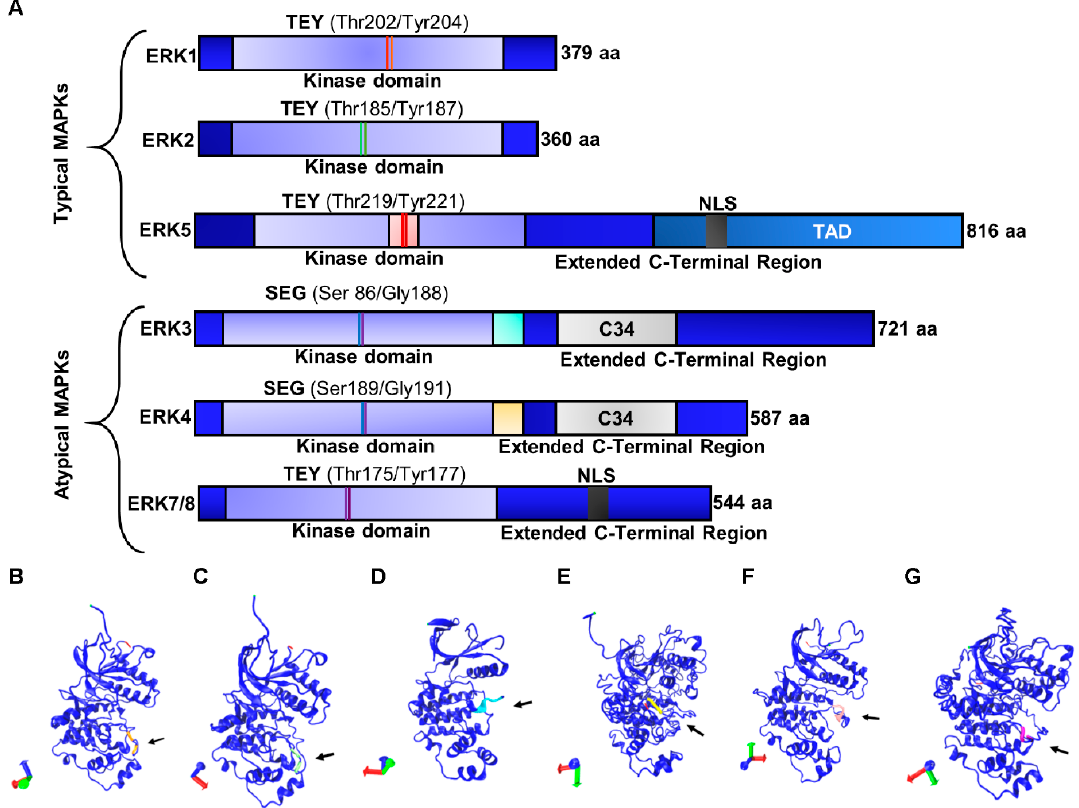
Figure 1. Schematic representation of ERK family members. ( A ) Domains of the typical and atypical kinases. N-terminus, C-terminus, and kinase domains are indicated. ( B – G ) Crystal structures of ERK proteins, depicting the phosphorylation sites (black arrows). ( B ) ERK1; the residues Thr202 and Tyr294 are shown in orange (PDB: 2ZOQ). ( C ) ERK2, Thr185, and Tyr187 are in green (PDB: 1TVO). ( D ) ERK3, Ser189, Glu190, and Gly191 are in cyan (PDB: 2I6L). ( D ) Homology model of ERK4 using I-TASSER; Ser186, Glu187, and Gly188 are in yellow. ( E ) ERK5, Thr219, Glu229, and Tyr221 are in pink (PDB: 4IC7). ( F ) Homology model of ERK8 generated with I-TASSER; Thr175 and Tyr177 are in purple. Table 1. ERK family members.